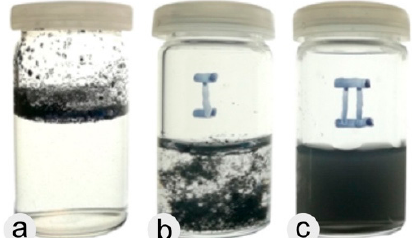
Figure 4. Different MWNT suspensions after various consecutive treatments. ( a ) Resuspension of pristine MWNTs in recrystallization buffer. ( b ) Sample I: -COOH functionalized MWNTs in recrystallization buffer after ultrasonication (20 min). ( c ) Sample II: further treatment of sample I by adding wtSbpA S-layer protein in the course of a second short (4 min) ultrasonication step.